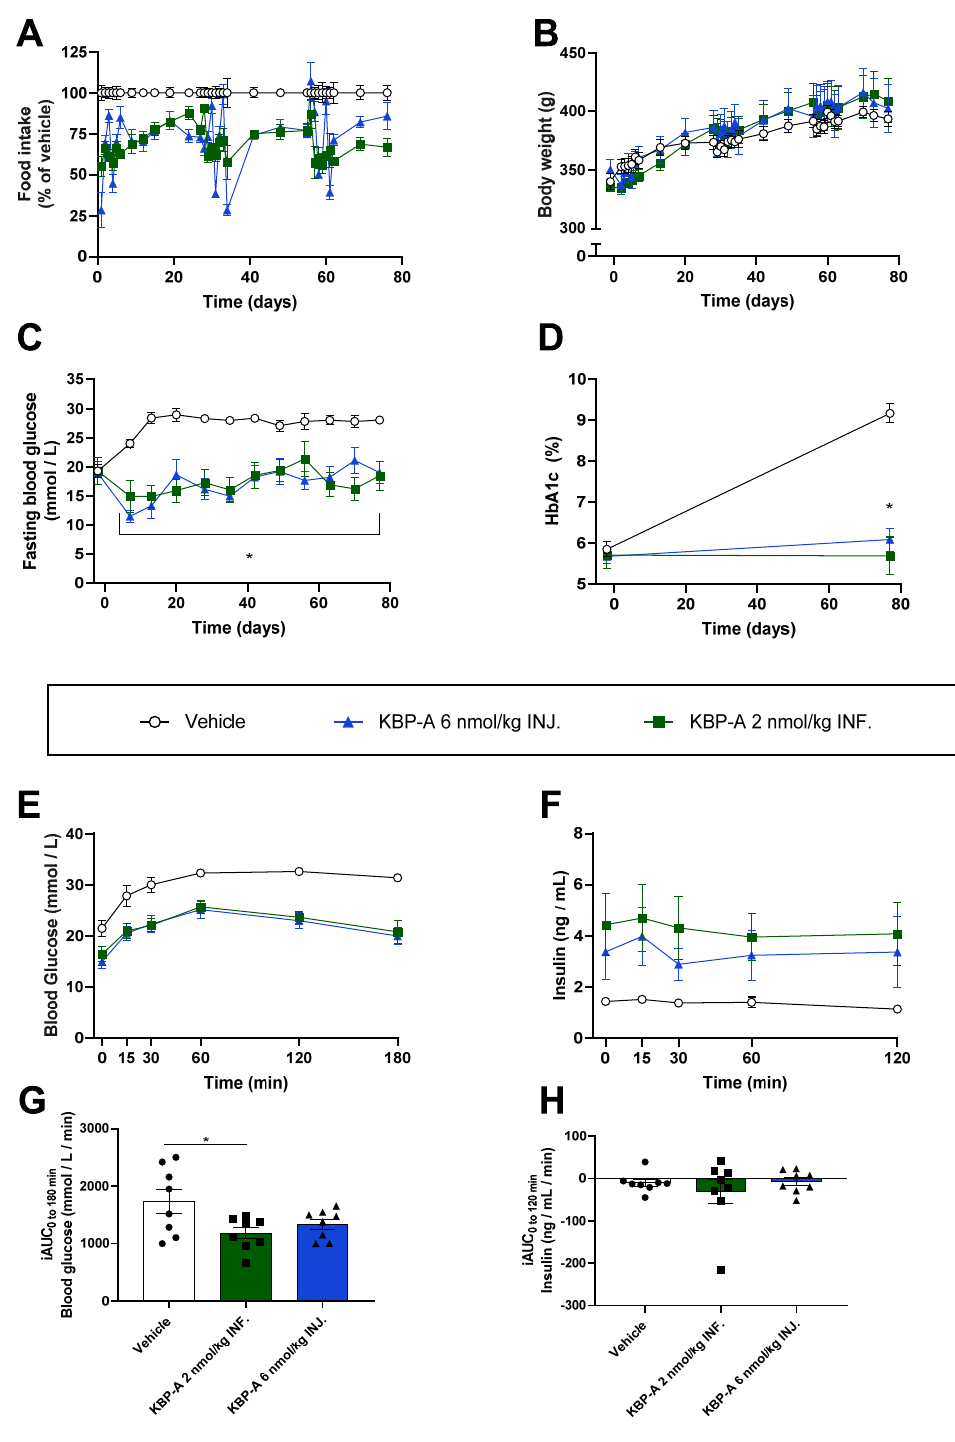
Figure 6. Intervention study in ZDF rats treated with saline, or KBP-A delivered by continuous infusion (INF., 2 nmol/kg QD) or by injection every 3rd day (INJ., 6 nmol/kg Q3D). The rats underwent surgery or SHAM when the infusion pump was inserted. Food intake ( A ) and body weight ( B ) were